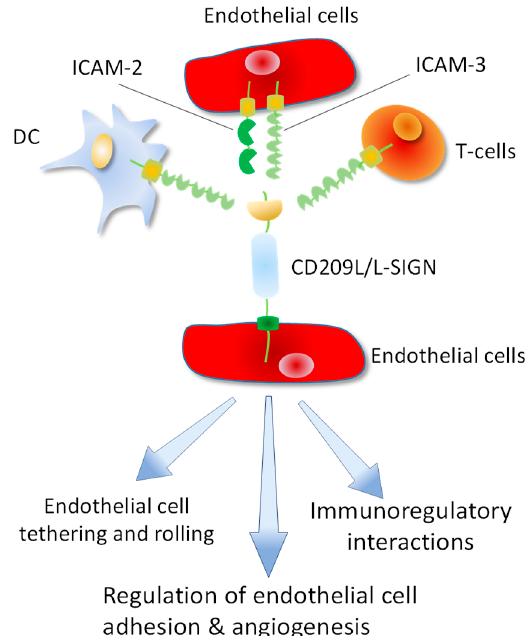
Figure 5. CD209L/L-SIGN mediates multiple cell-cell interactions between endothelial cells, DCs and T-cells. CD209L cellular ligands (ICAM2 and ICAM3) are expressed in DCs, T-cells and endothelial cells leading multiple immunoregulatory and other interactions between T-cells, DCs and endothelial cells. CD209L/ICAM2/ICAM3 interactions in endothelial cells can regulate endothelial adhesion and angiogenic properties of endothelial cells.